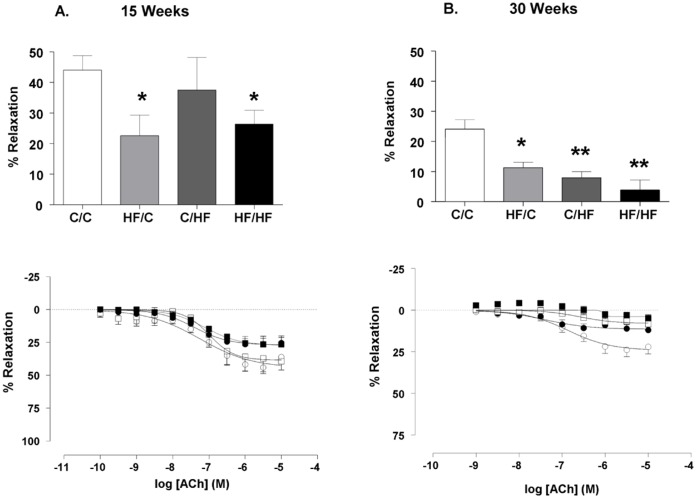
Impact of maternal HF-feeding on offspring vasorelaxation in the femoral artery.Cumulative dose response curves and % maximum response to the vasodilator (ACh) measured in the femoral artery of male mice offspring from four dietary groups at (A) 15 weeks (○ C/C n = 6, • HF/C n = 7, □ C/HF n = 6, ▪ HF/HF n = 7) and (B) 30 weeks of age. (○ C/C n = 8, • HF/C n = 6, □ C/HF n = 8, ▪ HF/HF n = 7). Data are mean ± SEM. Values significantly different between high fat fed offspring groups and control offspring (C/C) are indicated by * p<0.05, **p<0.001.